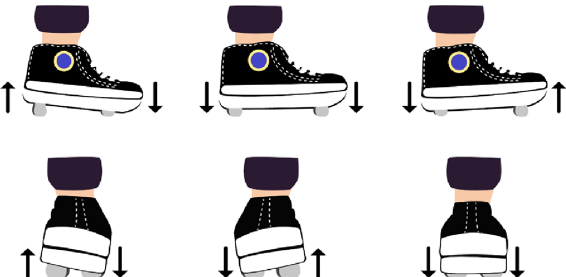
Figure 1. The RS has four pistons underneath each shoe. By changing their lengths, the pistons create a single plane that may be parallel or oblique to the sole’s plane. These changes take place during the swing phase, of each step, to provide a new and unpredictable support surface that is perceived only during the stance